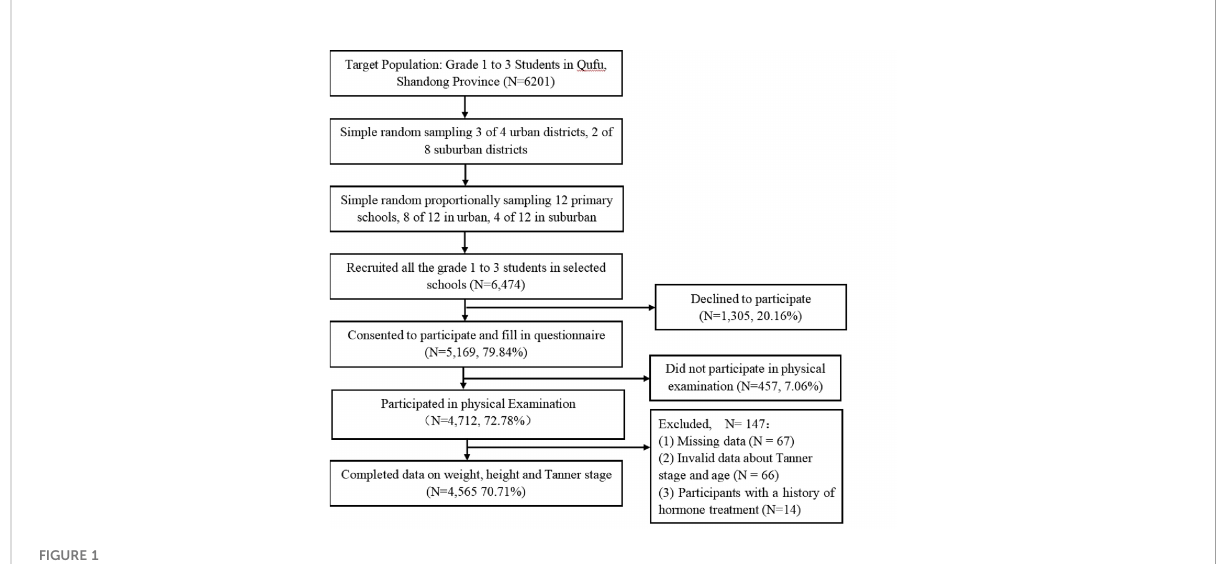
FIGURE 1 Flowchart of